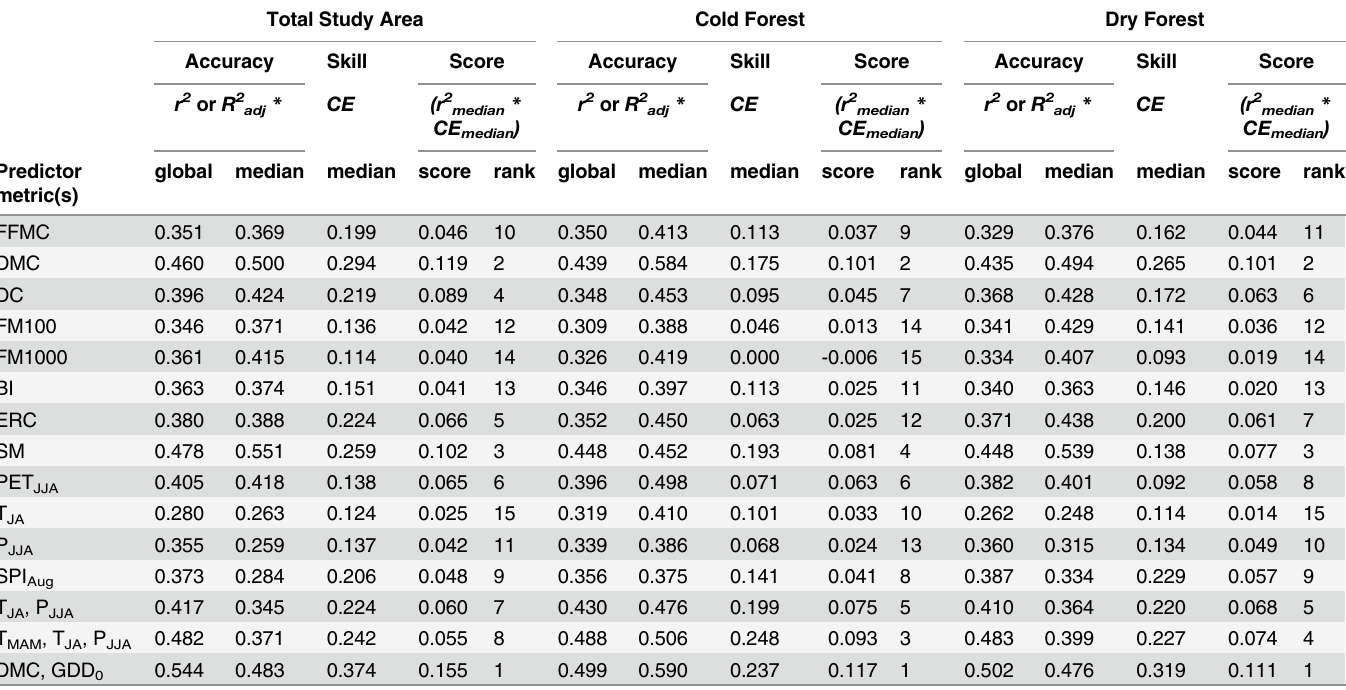
Table 2. Results for linear regression models predicting the natural logarithm of annual area burned.